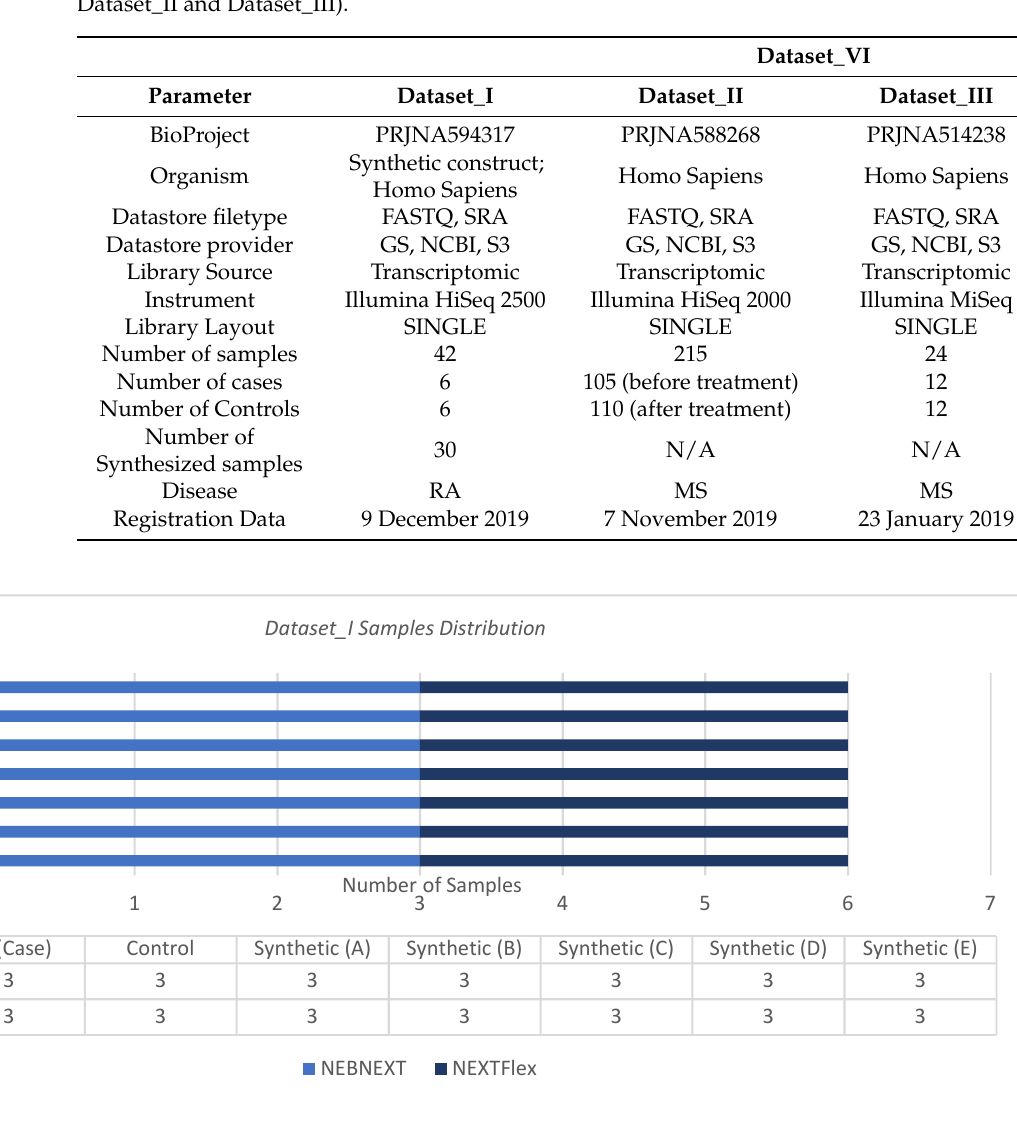
Table 1. Key specifications of the four studied datasets. (Dataset_VI was created by combining Dataset_II and Dataset_III).